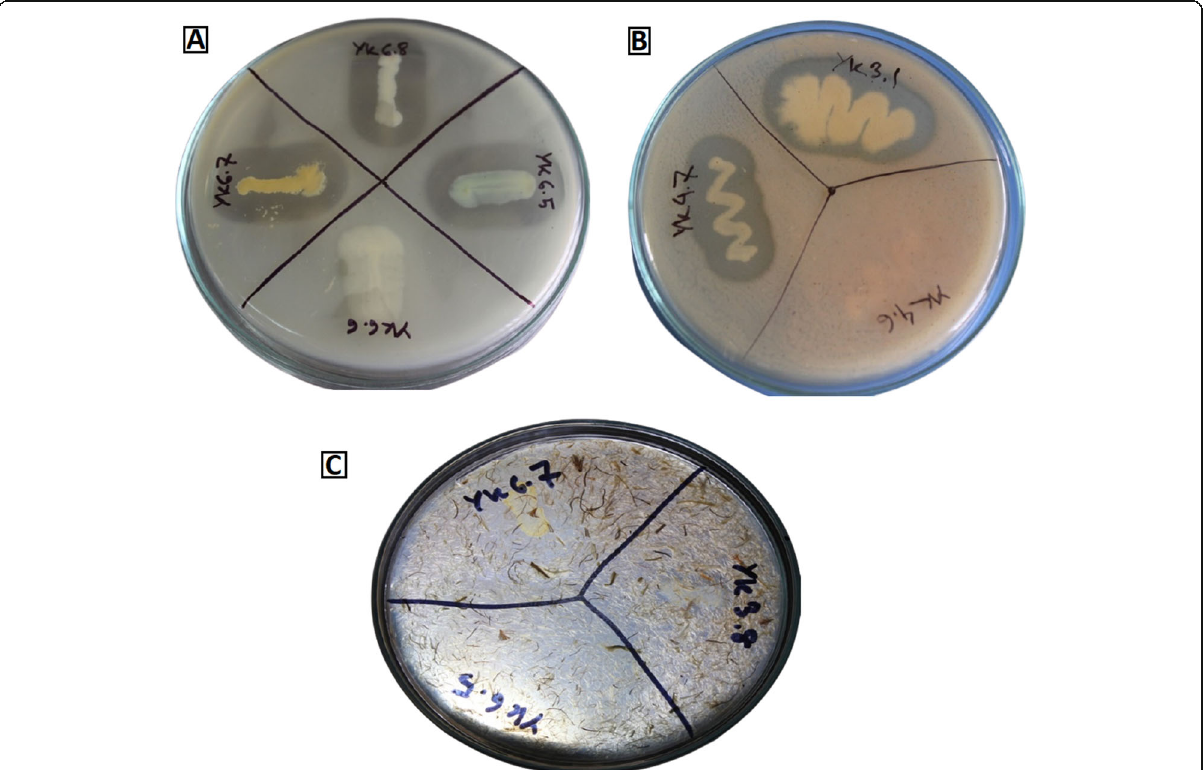
Fig. 1 Keratinolytic activity of present study isolates. a Zone of clearance on skim milk agar. b Zone of clearance on casein agar. c Zone of clearance on feather agar